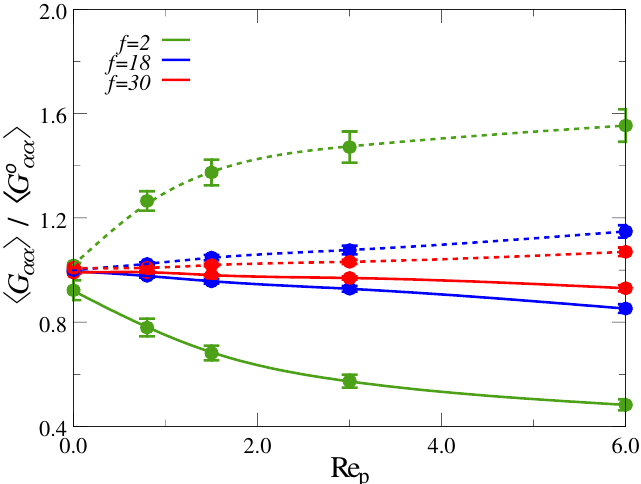
Figure 5. Components of the radius of gyration tensor averaged over the entire channel vs. flow strength Re p , normalized by the value at rest. Dashed lines show component in flow direction, (cid:104) G zz (cid:105) , and solid lines show component in gradient direction, (cid:104) G xx (cid:105)